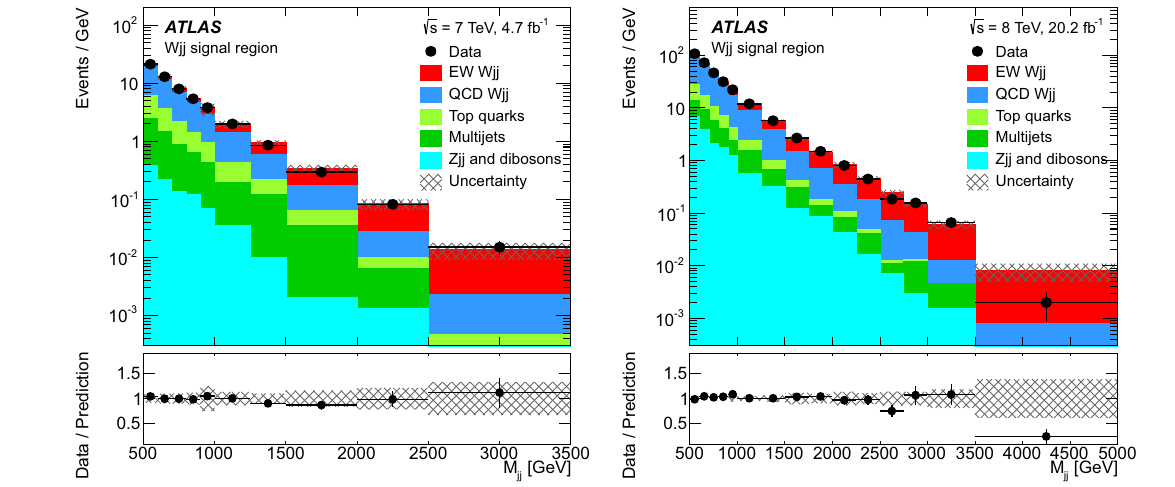
Fig. 9 Distributions of the dijet invariant mass for events in the signal region in 7 TeV ( left ) and 8 TeV ( right ) data, after fitting for the yields of the individual W jj processes. The bottom panel in each distribution